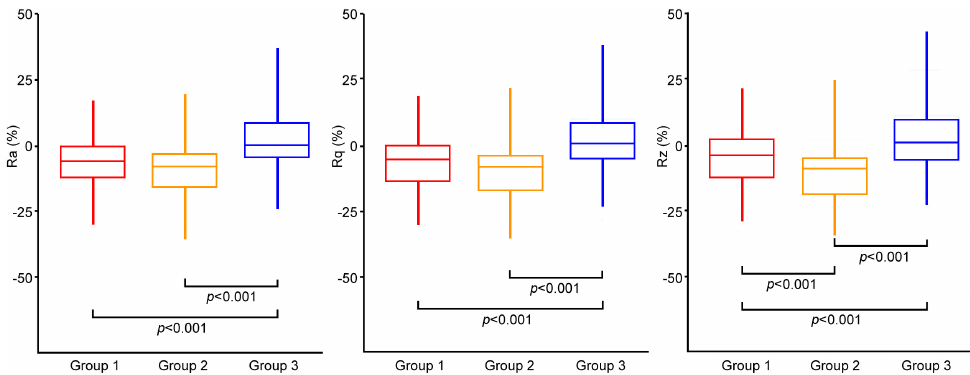
Figure 2. Box plot showing the distribution of the percentage change for Ra, Rq, and Rz parameters among the three groups. p -values of APC are reported.